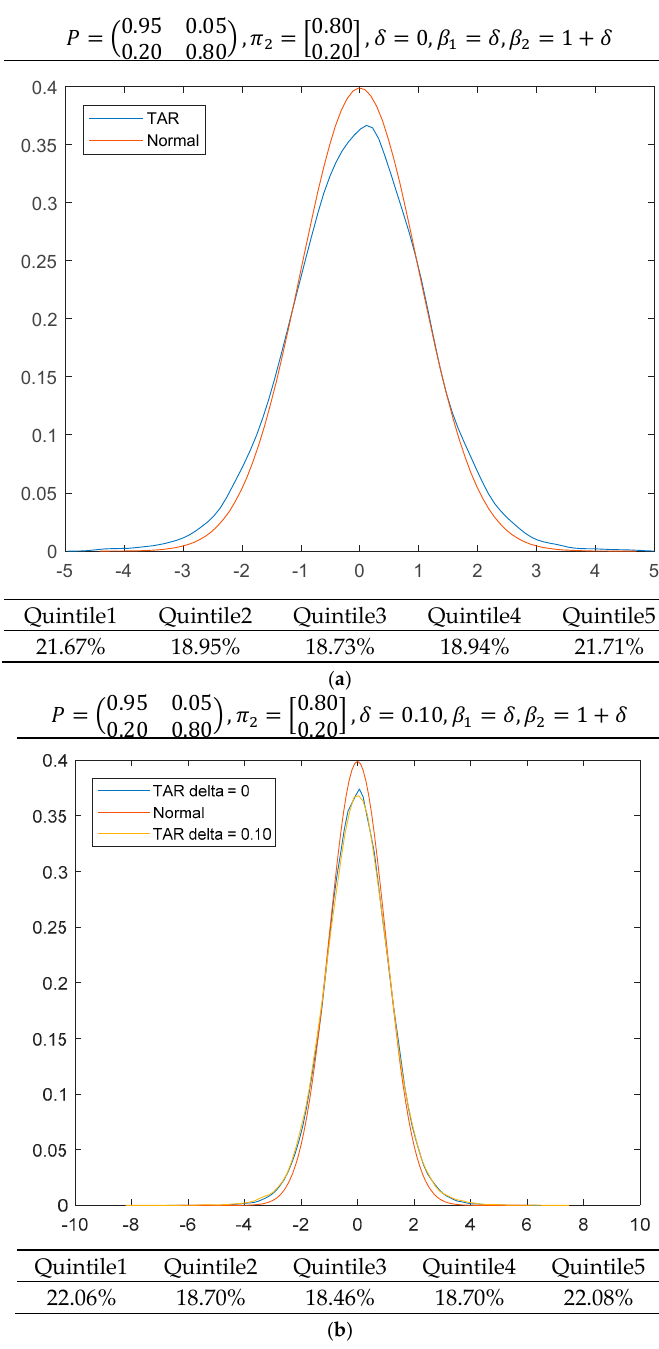
Figure 4. ( a ) Simulated Distributions for TAR(1) with π 2 as the steady state vector and δ = 0. ( b ) Simulated Distributions for TAR(1) with π 2 as the steady state vector and δ =